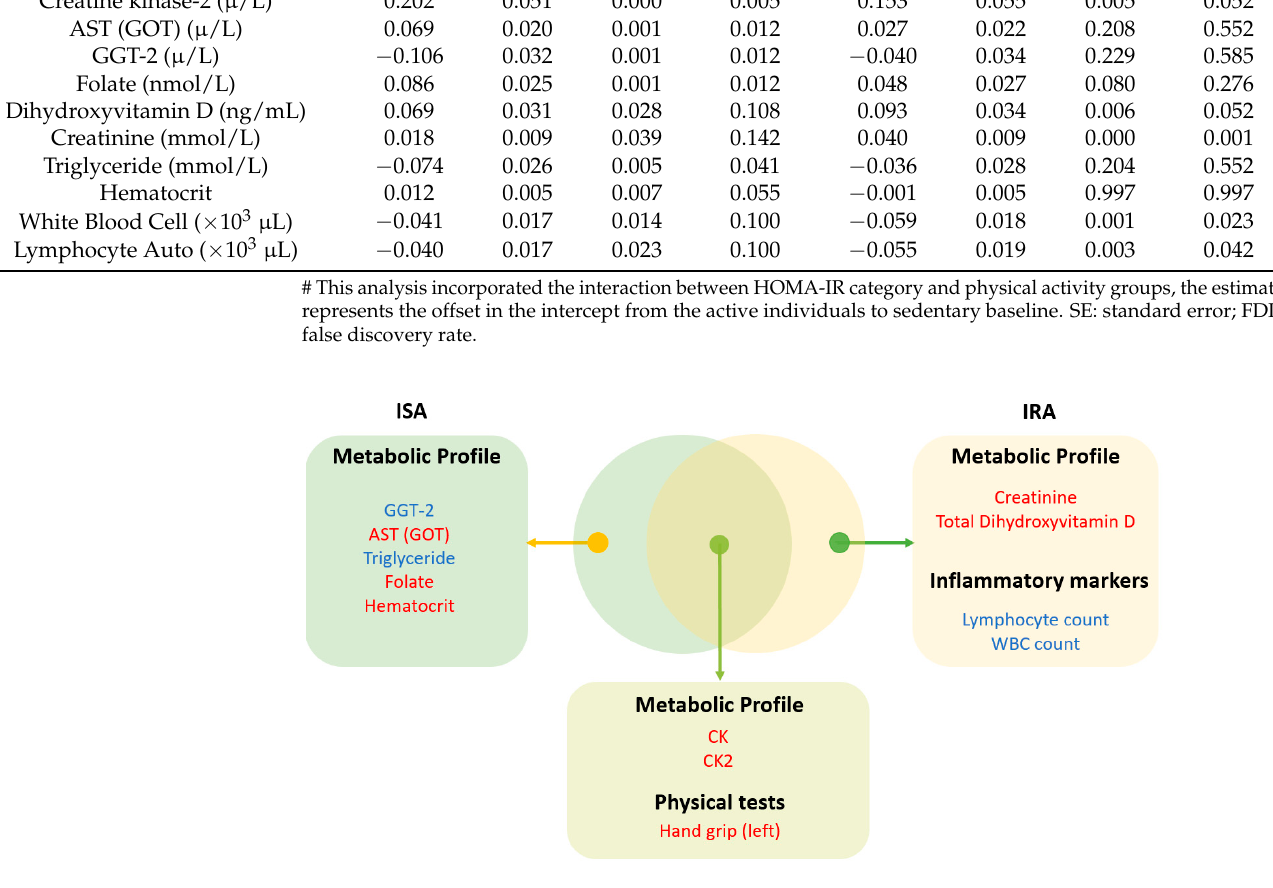
Figure 2 . Venn diagram representing the results from the linear regression analysis, incorporating the interaction between the HOMA-IR category and physical activity groups (visual representation of Table 2). Red/blue shows the clinical measurements that were higher/lower in the physically active group,